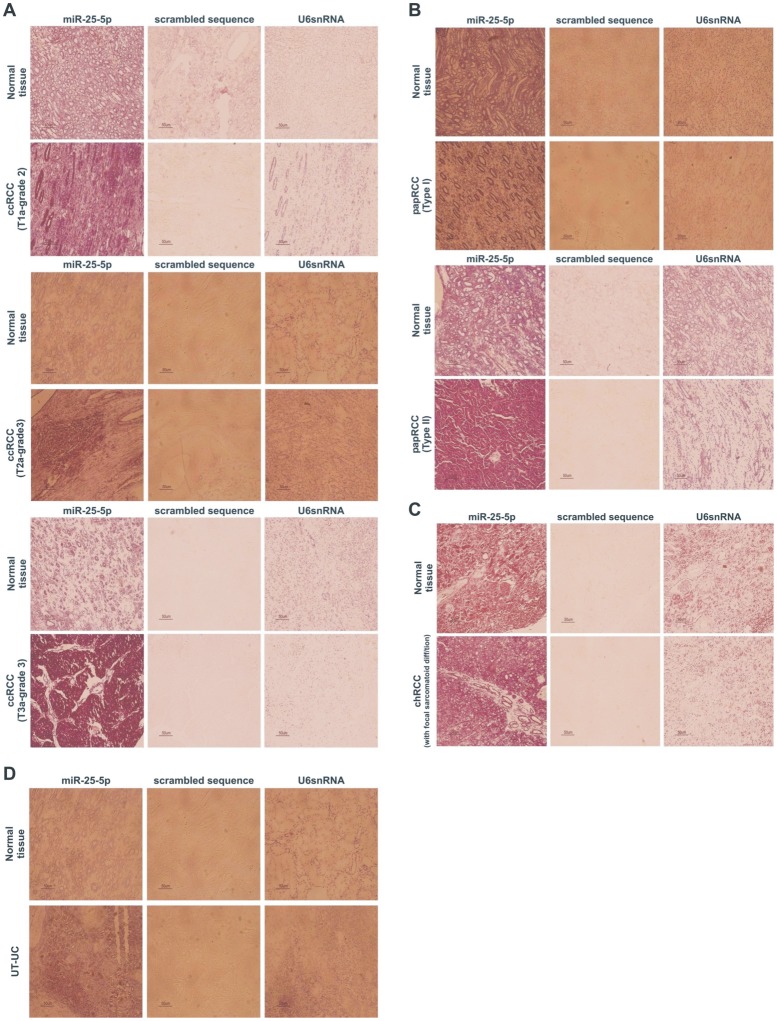
Locked Nucleic Acids-In Situ Hybridization (LNA-ISH).LNA-ISH for miR-25-5p in ccRCC (A), papRCC (B), chRCC (C) and UT-UC (D). miR-25-5p was confined to the cytoplasm both in normal and tumour sections. The nuclear expression of U6 snRNA (positive control) was confirmed in all the patient samples, whereas the scrambled oligonucleotide was negative in all samples. miR-25-5p high expression was confirmed in all ccRCC sections by LNA-ISH. ccRCCs of high stage and grade stained stronger miR-25-5p compared to lower stage and grade ccRCCs. Each ccRCC section was compared against its corresponding normal kidney section (A). papRCCs of type II stained stronger for miR-25-5p compared to type I papRCCs (B). Validating the qRT-PCR results, miR-25-5p did not stain stronger in chRCC sections vs. the normal tissue ones. This was also confirmed for chRCCs with focal sarcomatoid differentiation, suggesting that miR-25-5p does not play any role in the metastatic behavior of the tumour (C). Verifying the qRT-PCR results, miR-25-5p was not significantly stronger in UT-UC vs. the normal tissue sections (D).